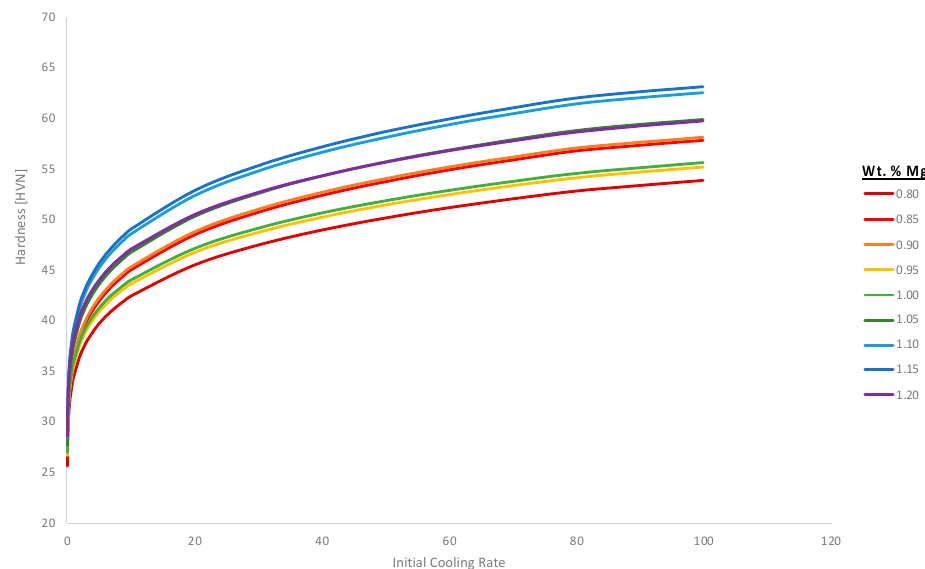
Figure 14. The hardness associated with the variation of magnesium content in the Al 6061 alloy, as a function of the initial solidification cooling rate, as presented herein, upon solidifying from a temperature of 700 °C.